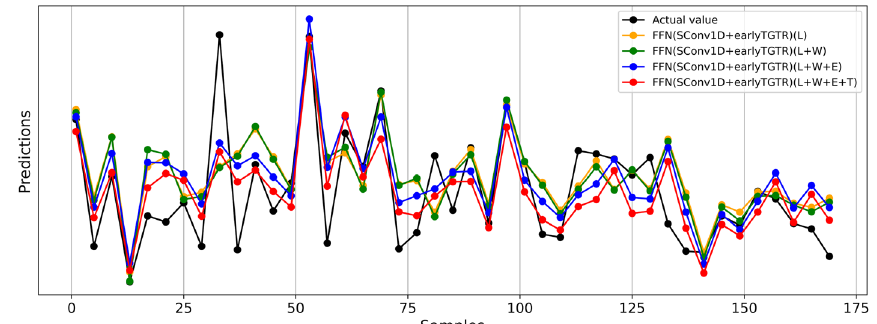
Fig. 4 Prediction results of the FFN (SCon1D